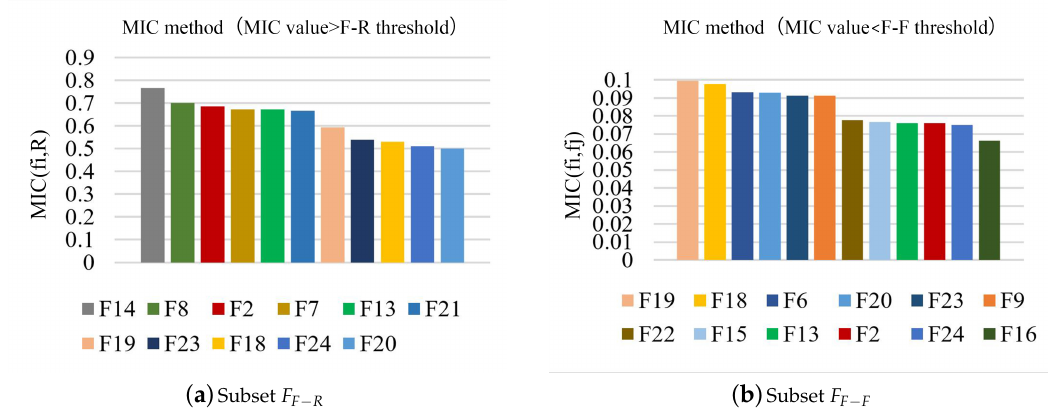
Figure 9. Initial bearings degradation indicator ( a ) subset F F − R and ( b ) subset F F − F .